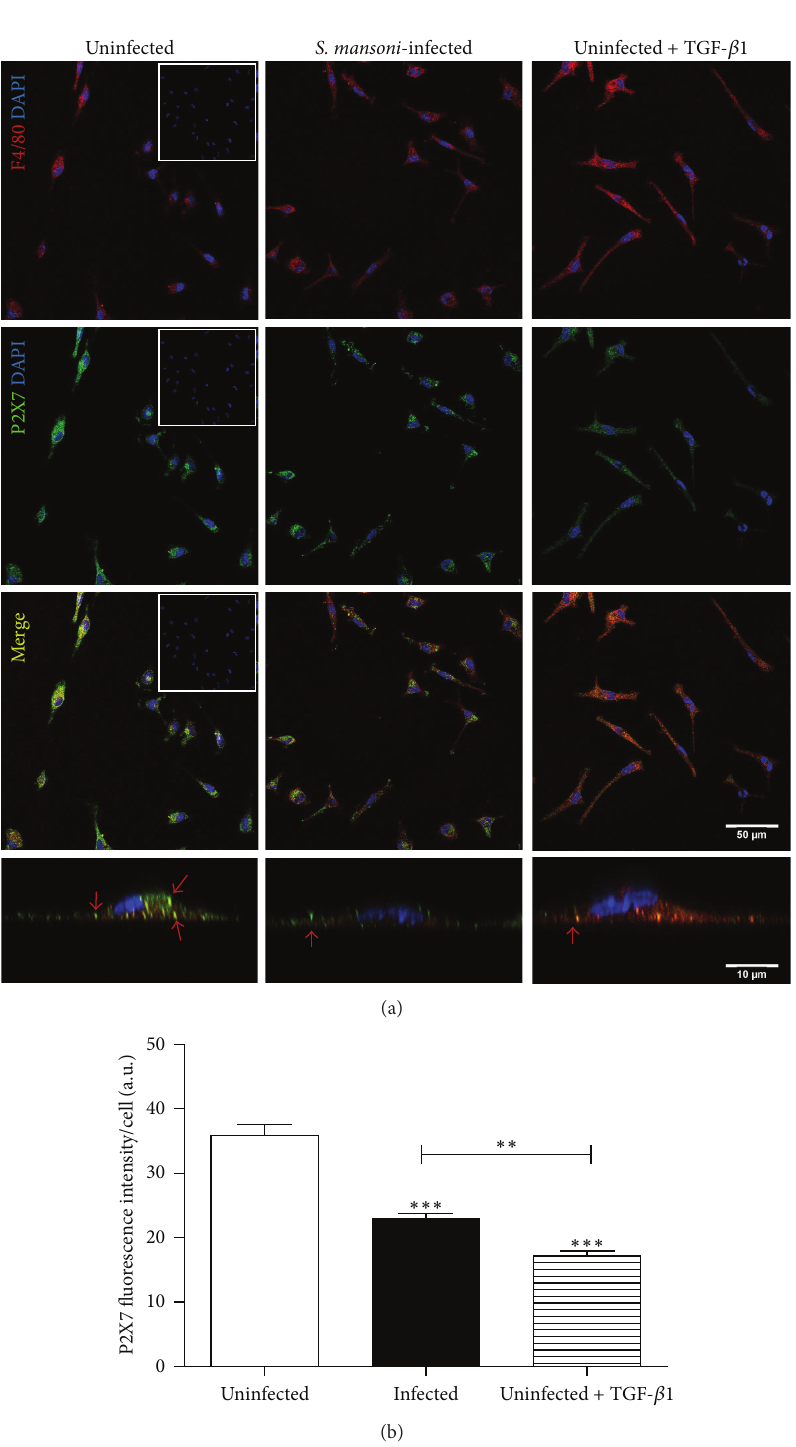
Figure 6: Confocal microscopy analysis of P2X7 receptor expression on the cell surface of macrophages. Cells were labelled with antibodies recognizing P2X7 receptors (green) and F4/80+ (red) as well as with DAPI (blue). (a) Representative images showing macrophages from uninfected (left column), S. mansoni -infected (middle column), and TGF- 𝛽 1-treated (right column; 5ng/mL, for 24 h) mice. The bottom row shows orthogonal slices of the representative labelled cells, with red arrows marking P2X7 expression on the plasma membrane. (b) Quantitative analysis of confocal microscopy data. The mean fluorescence intensity, showing cell surface P2X7 receptor expression in peritoneal macrophages from uninfected mice (white bar), S. mansoni -infected (black bar), and TGF- 𝛽 1-treated (hatched bar; 5 ng/mL, for 24 h) mice, was obtained from pixels intensity using ImageJ software (see methods). Inset: negative controls (macrophages incubated with secondary antibodies only). 𝑛 = 6 replicates from 3 animals for each condition ( ∗∗∗ 𝑃 < 0.001 versus control, 𝑃 < 0.01 TGF- 𝛽 1 versus infected group; one-way ANOVA followed by post hoc Newman-Keuls